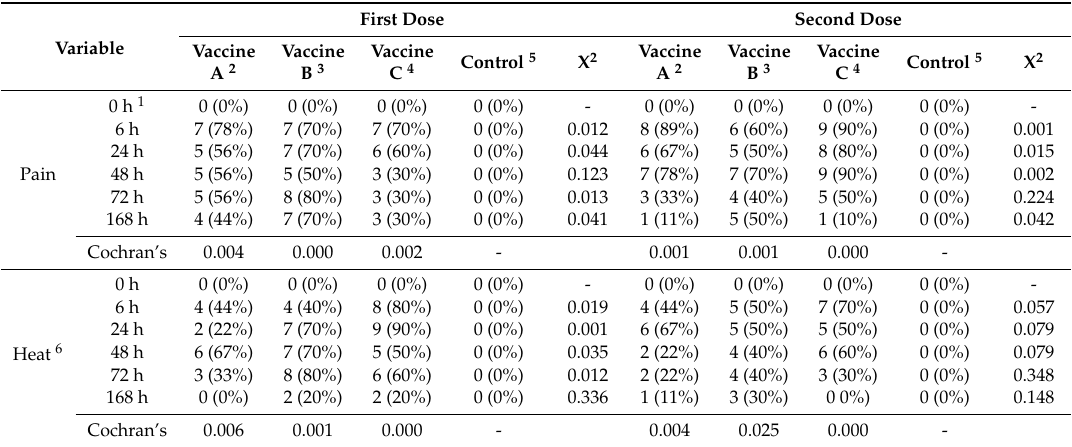
Table A1. Impact of vaccination against BVDV and BHV-1 with di ff erent commercial formulations in animals on a presence of cardinal signs of inflammation.